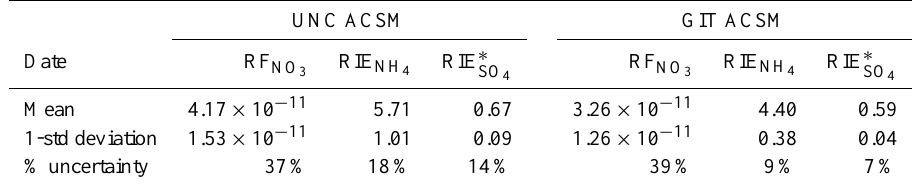
Table 2. Statistics of calibration values obtained from UNC and GIT ACSMs since mid 2011 to early